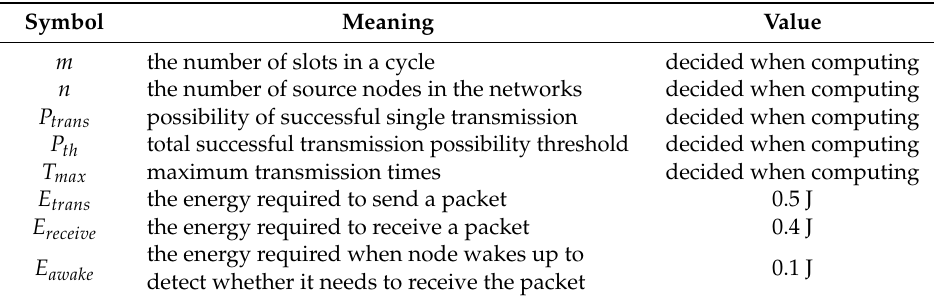
Table 1. Symbols in the